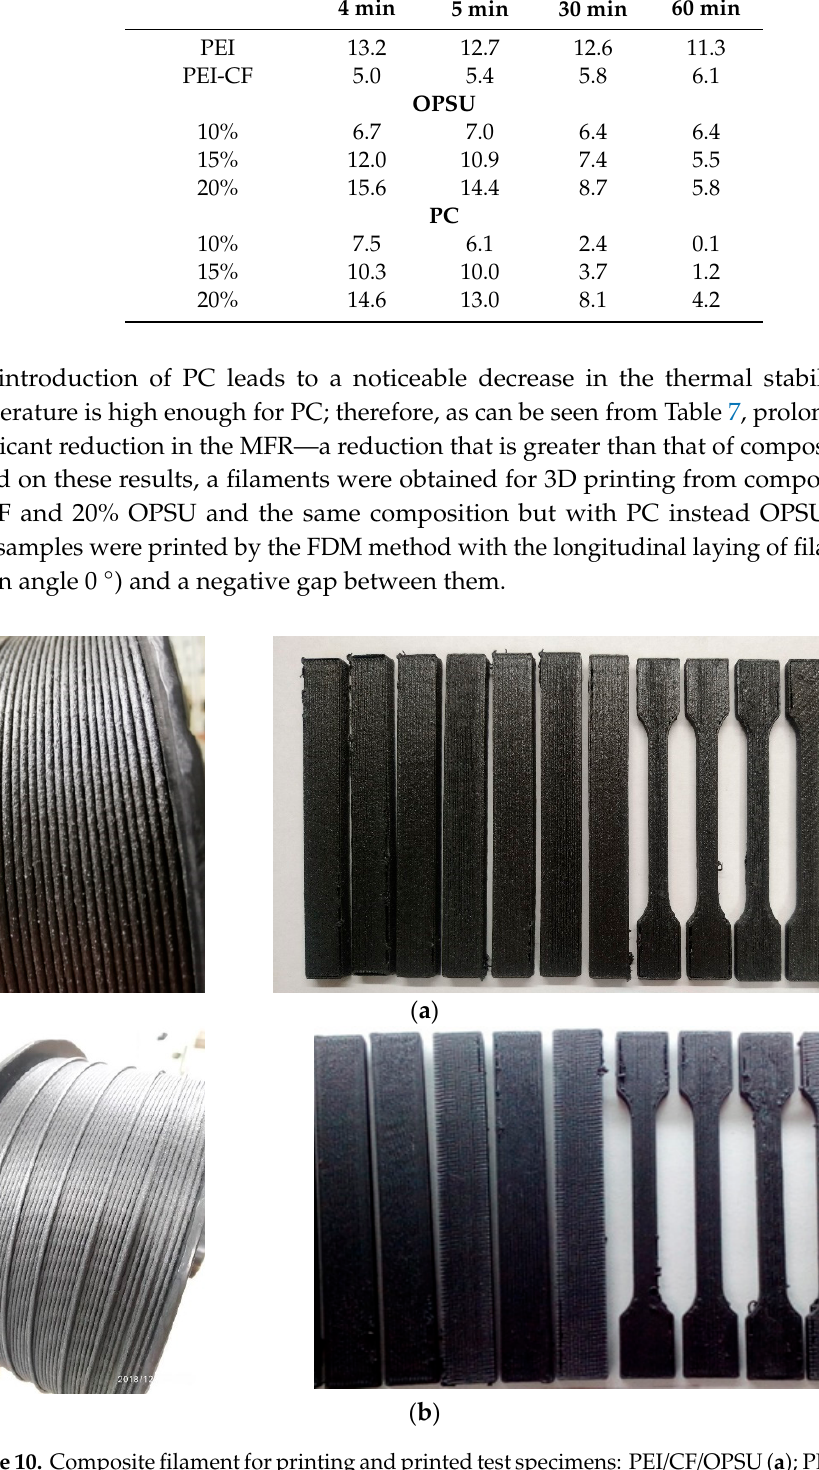
Table 8. Mechanical properties of the printed composites based on PEI/CF with OPSU and PC.